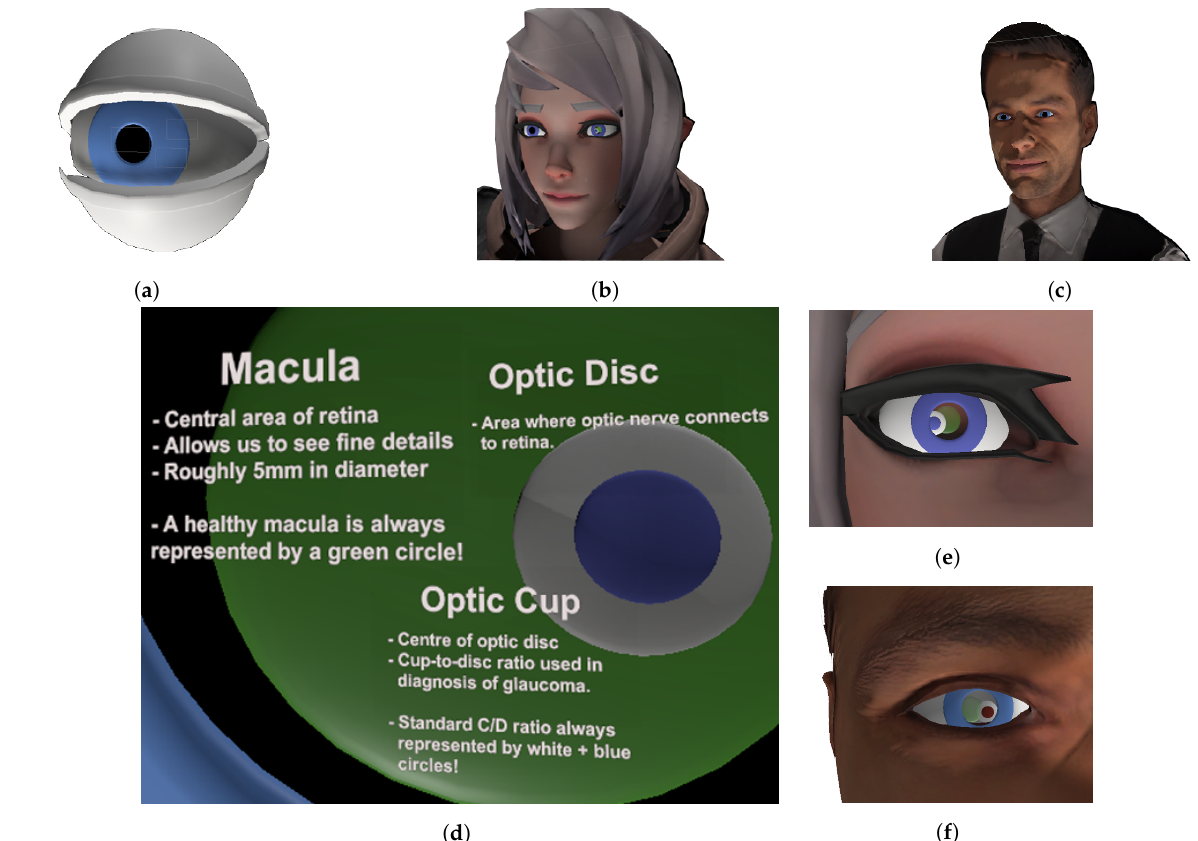
Figure 2. Virtual avatars and eye fundus close up for eye examination. ( a ) Floating eye. ( b ) ’Lyette’ virtual patient. ( c ) ’Jimothy’ virtual patient. ( d ) Floating eye fundus. ( e ) ’Lyette’s’ eye fundus. ( f ) ’Jimothy’s’ eye